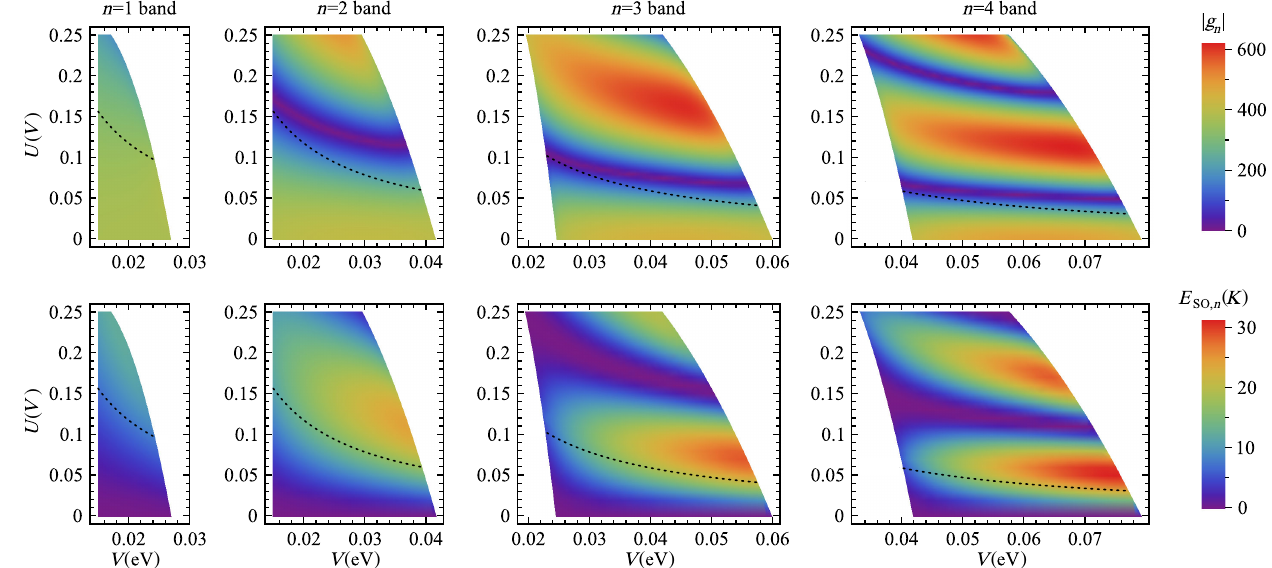
FIG. 5. Color-scale plot illustrating the pronounced oscillations in the effective g factor (upper row) and spin-orbit energy (lower row) for the four lowest confined subbands. The horizontal axis represents the depth V of the confinement potential used to define the wire, while the vertical axis corresponds to the potential drop U across the quantum well due to a perpendicular electric field. Data were extracted from numerical simulations of a d ¼ 70 - (cid:5)A quantum well supporting a wire of width W ¼ 800 (cid:5)A , assuming a smooth confinement potential. For a given band, the g factor and spin-orbit energy are well defined only if that band supports confined ¼ 0 . This condition cuts off the plots at small and large V . Dashed lines indicate the crossover between perturbative and states at k x nonperturbative Rashba coupling regimes according to Eq.